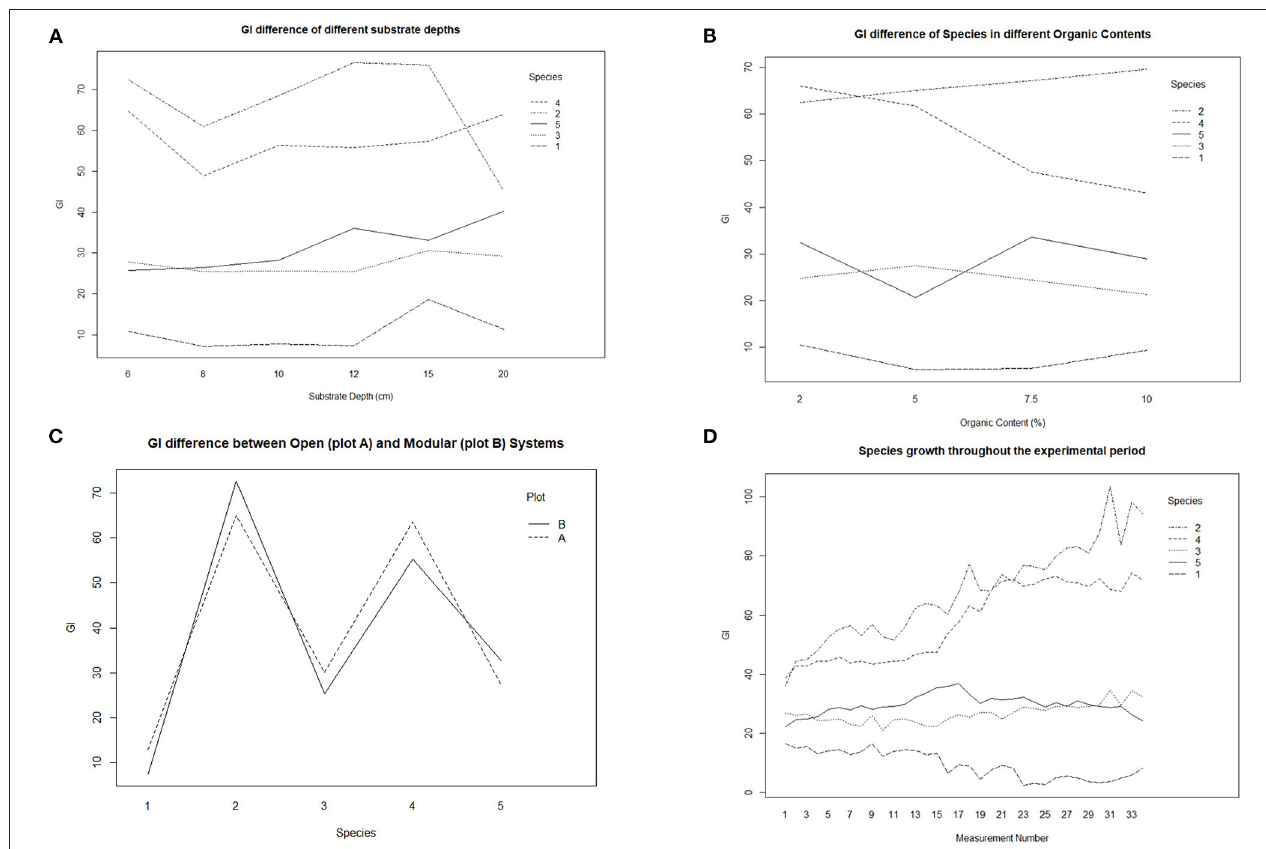
FIGURE 5 | Interaction plots of species in relation to substrate depth, organic content, type of green roof system, and measurement number. (A) GI difference of different substrate depths, (B) GI difference of species in different organic contents, (C) Mean GI difference between Open (plot A) and Modular (plot B) Systems and (D) Species growth throughout the experimental period (Measurement numbers: 1-34); where plant species: 1: Sedum sediforme, 2: Medicago arborea, 3: Drosanthemum floribundum, 4: Lavandula angustifolia and 5: Lampranthus spectabilis. Source: